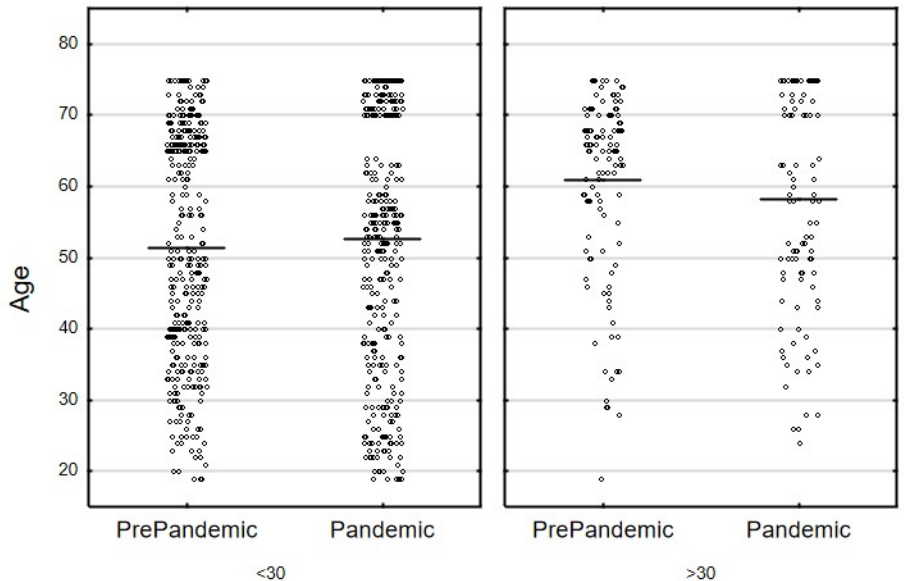
Figure 1. Distribution of the age variable in the PrePandemic vs. Pandemic samples stratified by the BMI category (<30 vs. ≥ 30) (two-way ANOVA: F (1, 960) = 2.538; p = 0.111, horizontal lines illustrate the means).